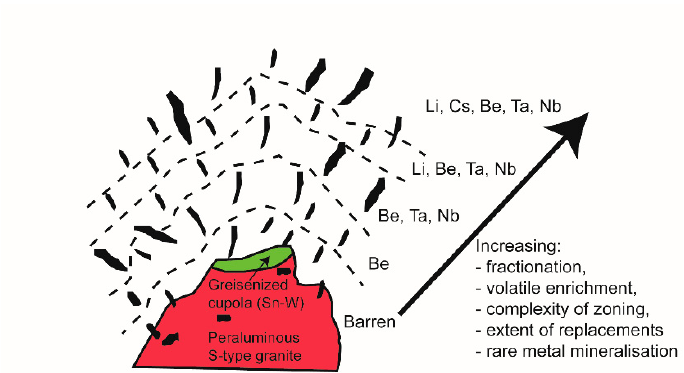
Figure 2. Traditional model of regional zonation and rare metal enrichment of pegmatites and pegmatite fields related to S-type granite plutons implying that zoned pegmatite fields are related to and have a similar age as a nearby granite intrusion (modified from [26]). This model is currently challenged by a number of authors who outline evidence for an anatectic origin of pegmatite melts, e.g., [4,13,36,37,47]. Whilst pegmatite fields can be zoned, the zonation is in some cases not spatially related to a pluton, but to individual pods of pegmatitic melt.